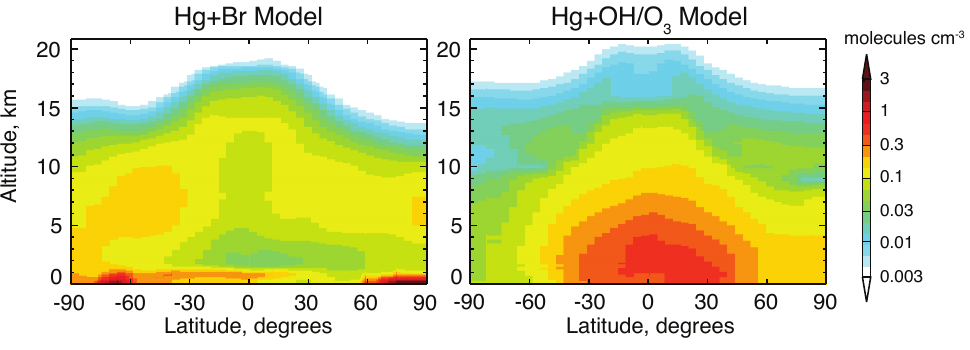
Fig. 3. Annual zonal-mean distribution of the Hg 0 oxidation rate in GEOS-Chem under the Hg+Br and Hg+OH/O 3 chemical